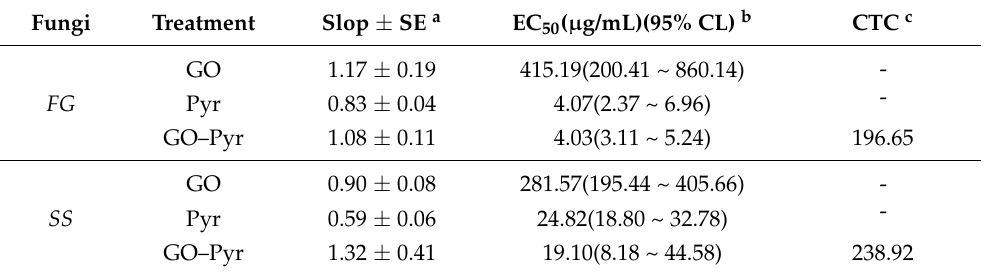
Table 3. Synergistic effects of GO–Pyr nanocomposite on the mycelial growth of FG and